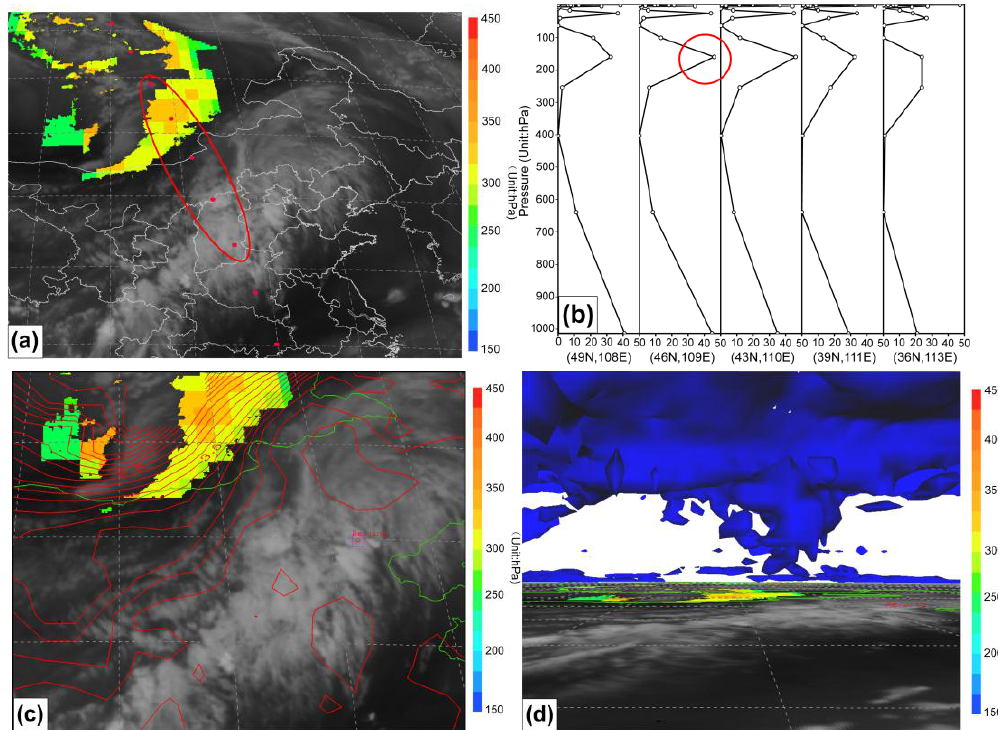
Figure 5 . ( a ) The lowest boundary of dry intrusion (hPa) at 0500UTC July 21,2012 superimposed with Figure 5. ( a ) The lowest boundary of dry intrusion (hPa) at 0500UTC 21 July 2012